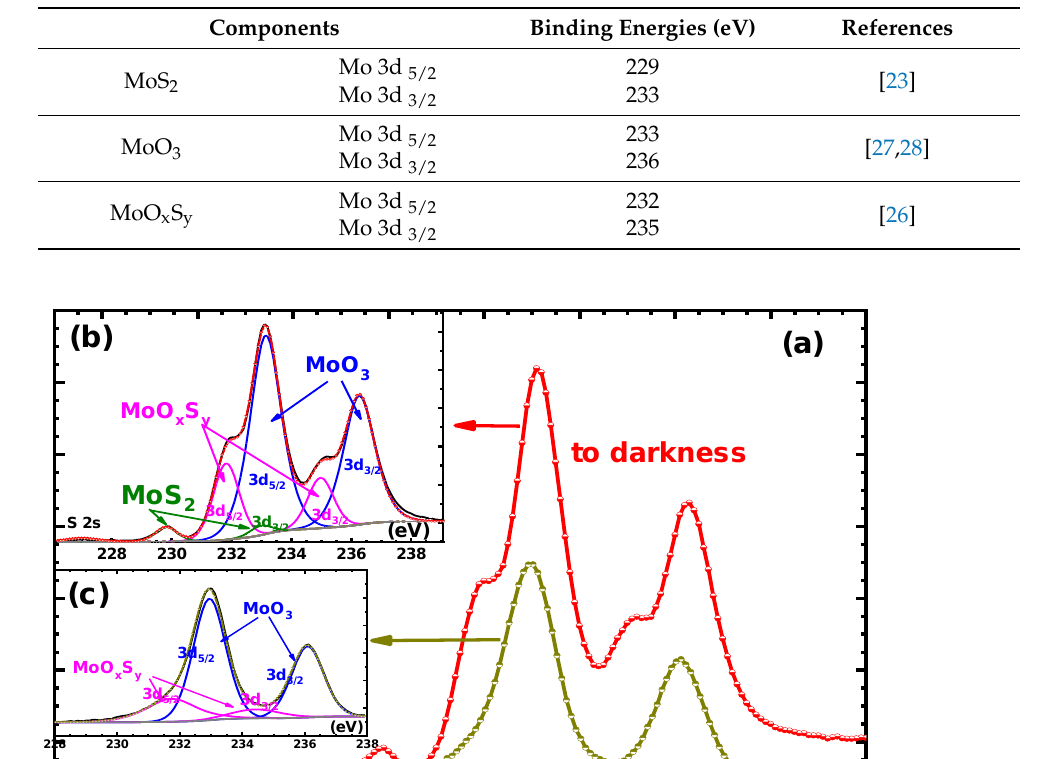
Table 1. XPS-binding energies of MoS 2 , MoO 3, and MoOxSy.